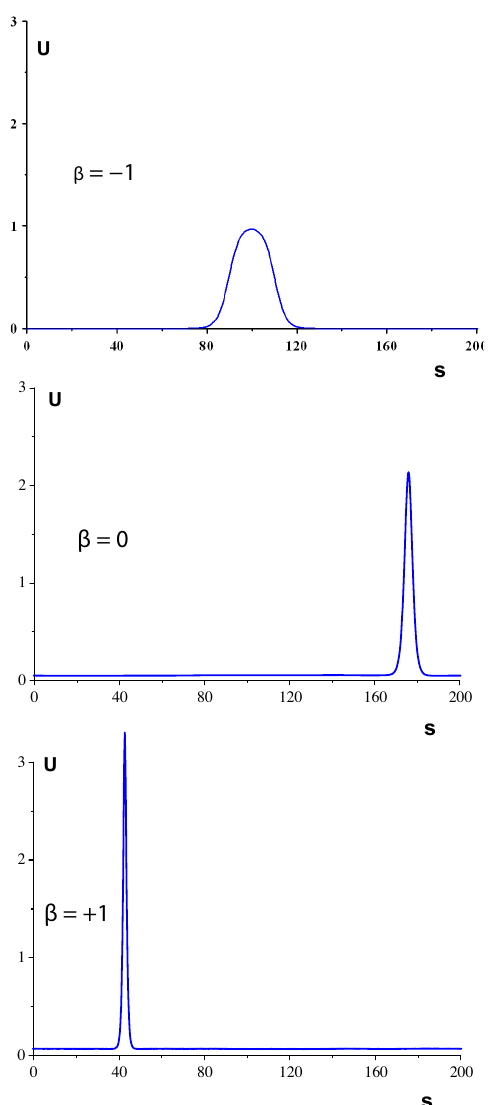
Fig. 6. Numerical simulation of the evKdV equation (6) with α = 1, λ = 1 and β varies from − 1 to 1, showing the transformation of a “table-top” solitary wave to a KdV “sech 2 ”-KdV solitary wave at the critical point, and further evolution as a solitary wave tending to a